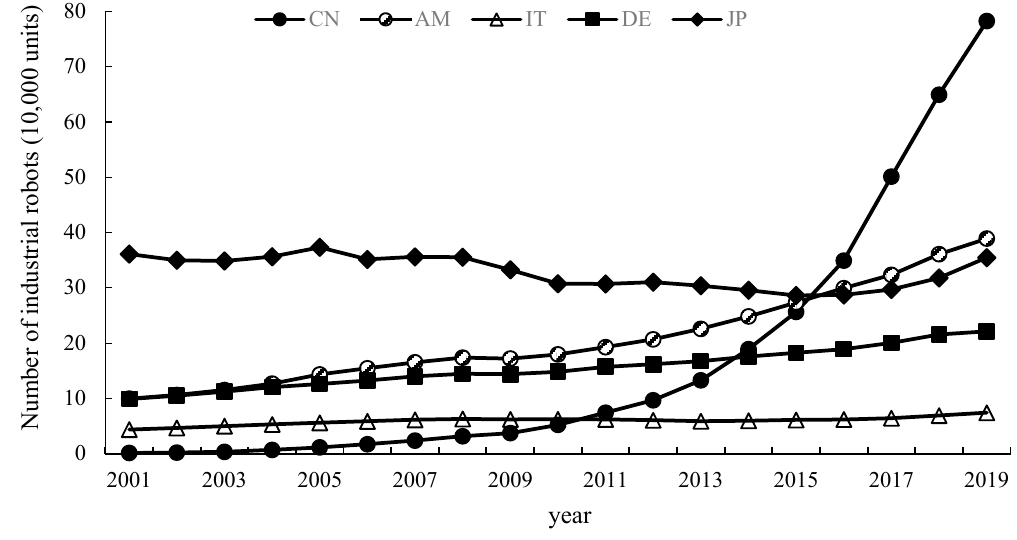
Figure 4. Comparison of emission intensity before and after the pilot policies.